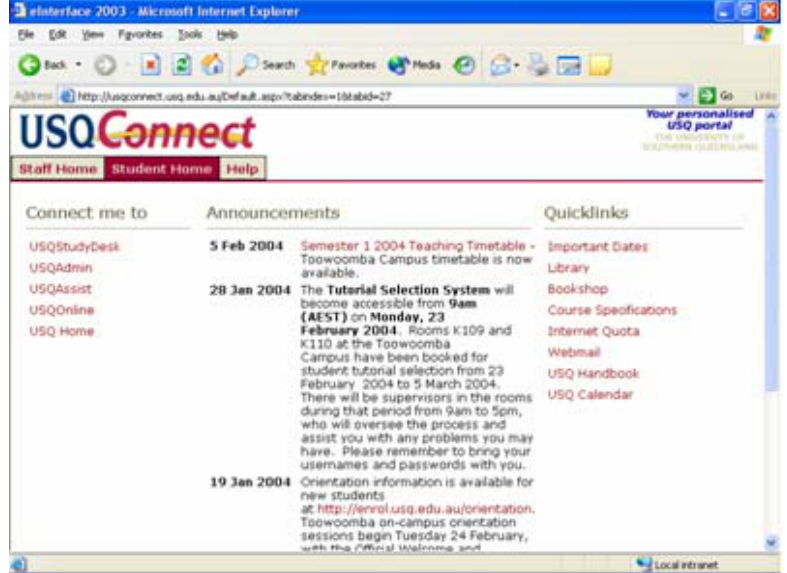
Figure 10. USQConnect